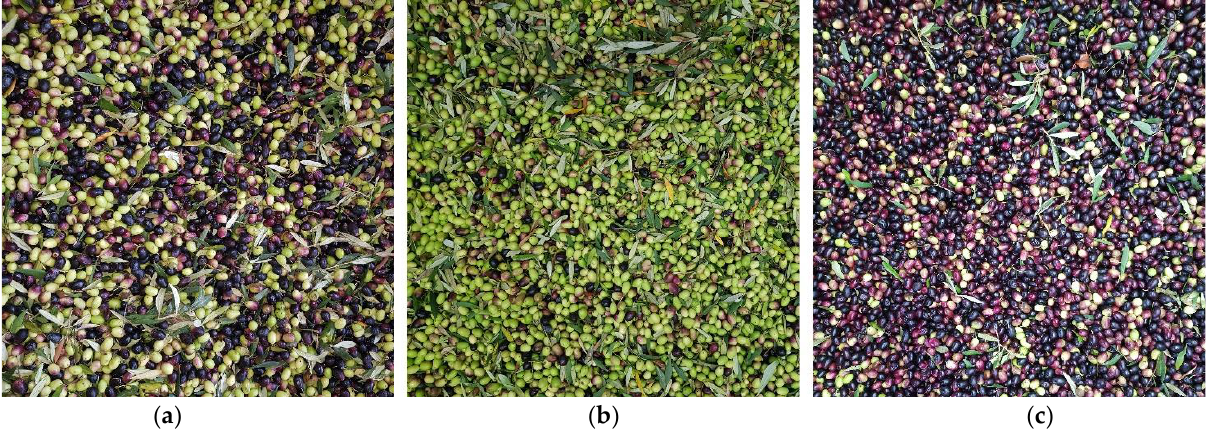
Figure 2. ( a ) “mixed”, ( b ) “green” and ( c ) “black” olives classes.